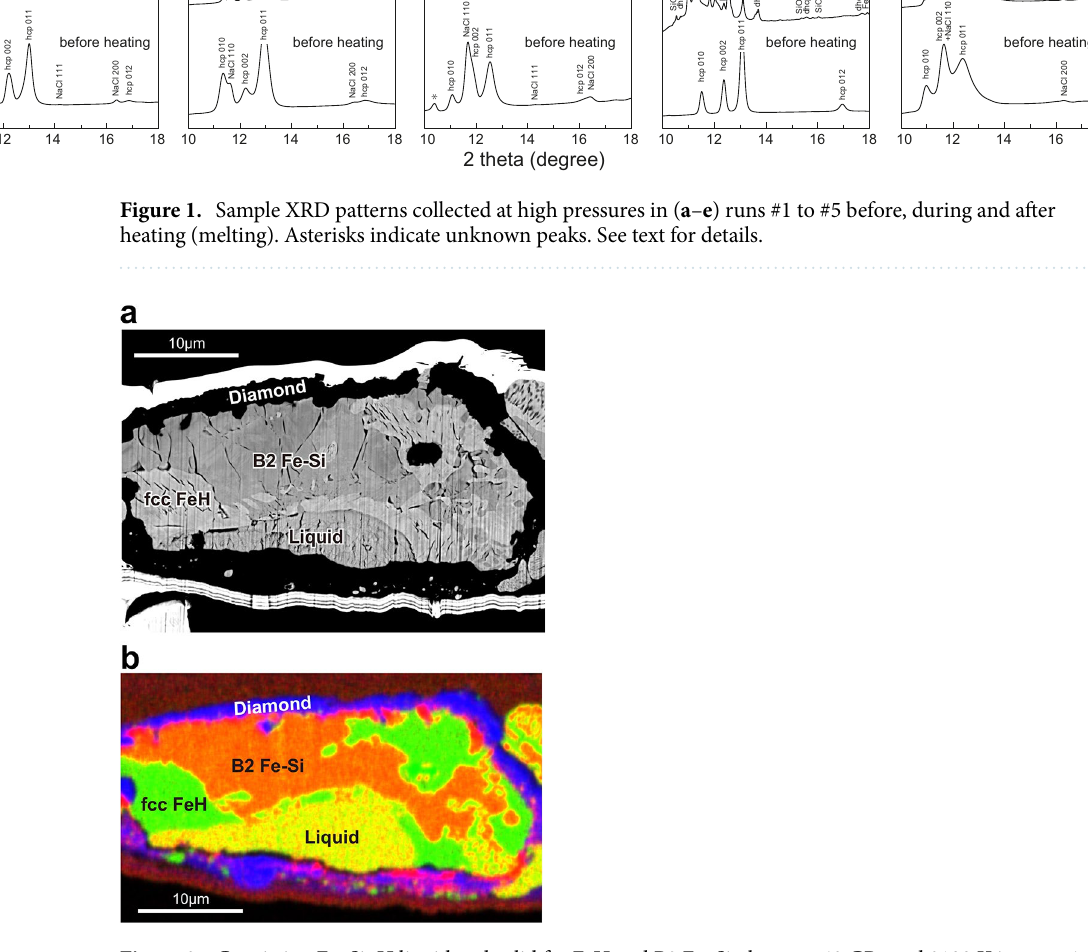
Figure 2. Coexisting Fe–Si–H liquid and solid fcc FeH and B2 Fe–Si phases at 48 GPa and 2100 K in run #4 using Fe–Si and C n H 2n+2 paraffin as starting materials. ( a ) Back-scattered electron image and ( b ) combined X-ray elemental map of Fe (green) + Si (red) + C (blue). Bubbles and cracks in ( a ) indicate that hydrogen was present in liquid and solids at high pressure and escaped during